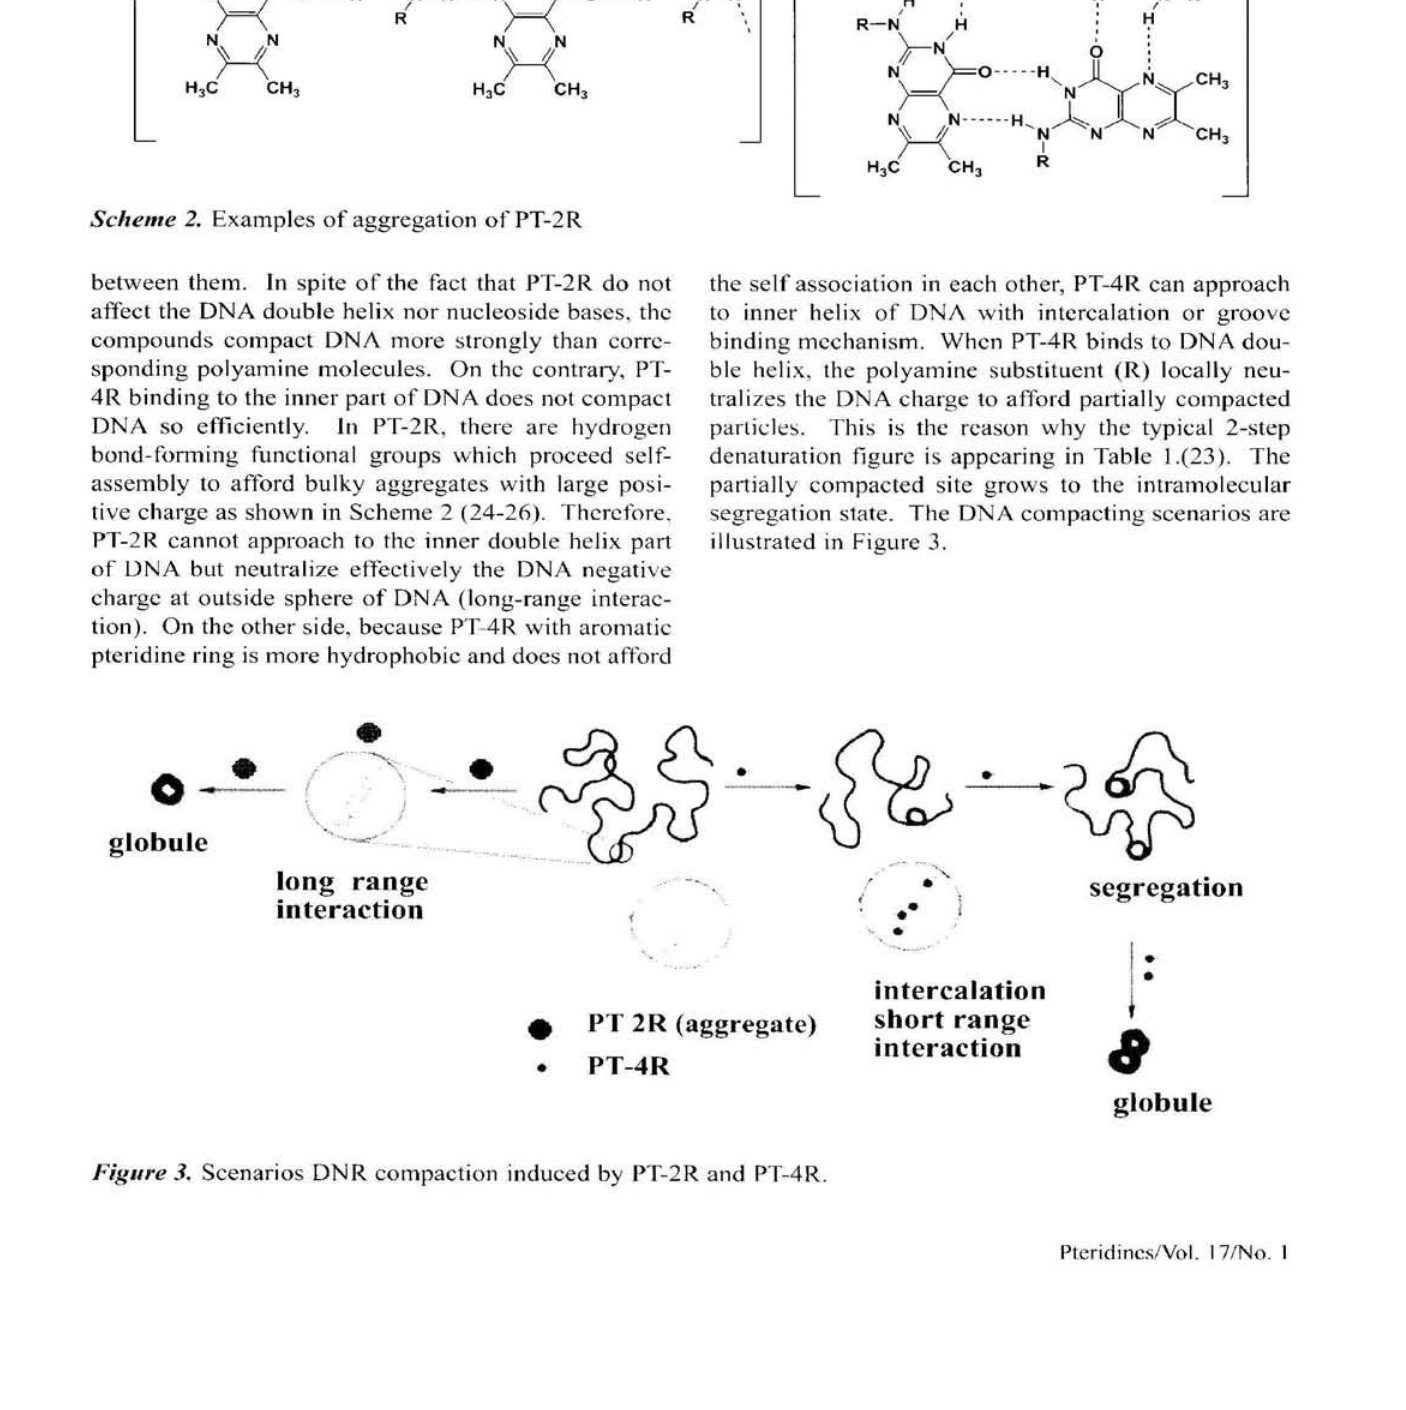
Figure 3. Scenarios DNR compaction induced by PT-2R and PT-4R.